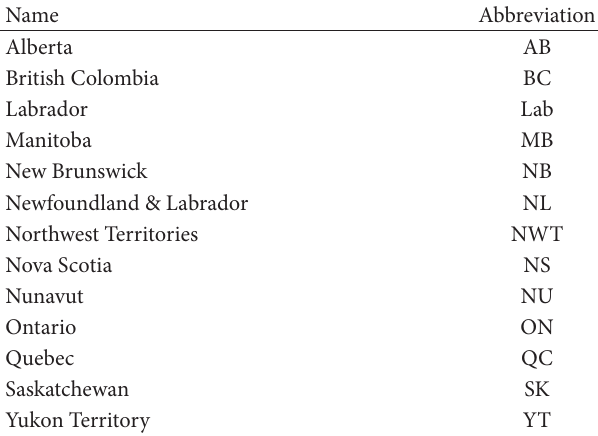
Table 5: Canadian provinces/territories: